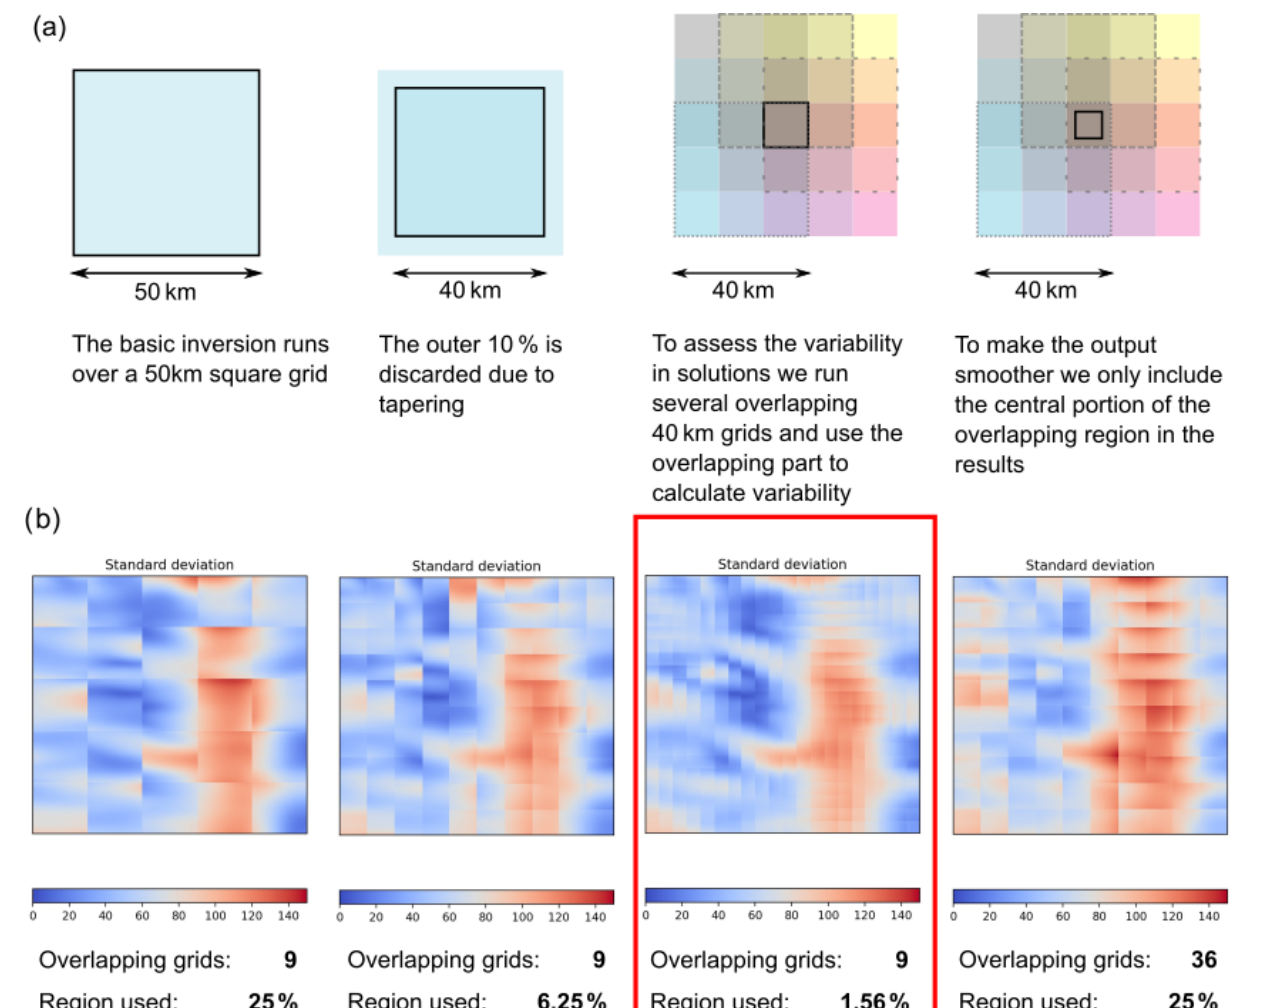
Figure 4. (a) Multiple overlapping grids are used in the inversion when applied to real data to allow the variability between solutions to be studied. (b) The effect of changing the number of overlapping grids and the fraction of the overlapping central region used to calculate the standard deviation of bed topography from the inversion in a roughly 60km by 60km